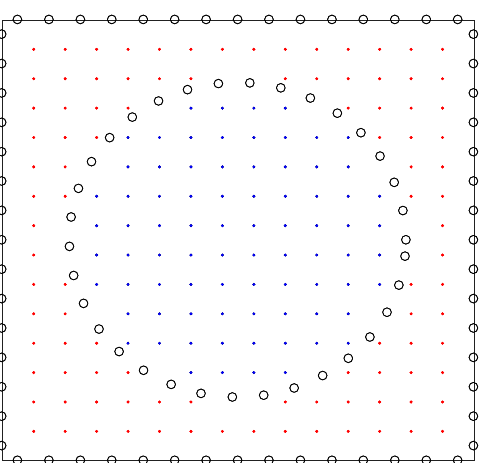
Figure 5. Nodes distribution for the unit cell of phononic crystal with circular scatterer, where the blue nodes ‘.’ in the circular scatterer, the red nodes ‘.’ in the matrix, and the black nodes ‘o’ on the periodic boundaries and interface boundary.